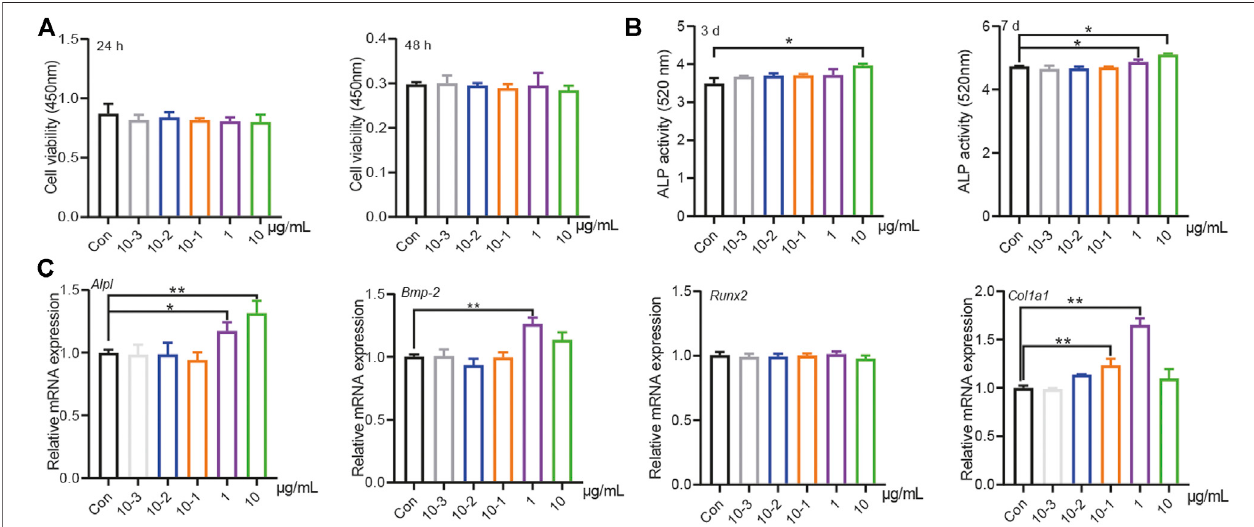
FIGURE 1 | PT stimulated osteogenic differentiation of BMSCs. (A) The effects of different concentration (10 – 3 , 10 – 2 , 10 – 1 , 1, 10 μ g/ml) PT on proliferation in BMSCsat24or48 h,therawdatarepresentedthemean ± SD; (B) TheeffectsofdifferentconcentrationPTonthesecretionofALPinBMSCsat3rdorseventhday,the raw data represented the mean ± SD; (C) The effects of different concentration PT on mRNA of osteogenic related factors in BMSCs, the normalized data represented the mean ± SD. * p < 0.05 vs Con, ** p < 0.01 vs Con, analyses were done twice and obtained comparable results.